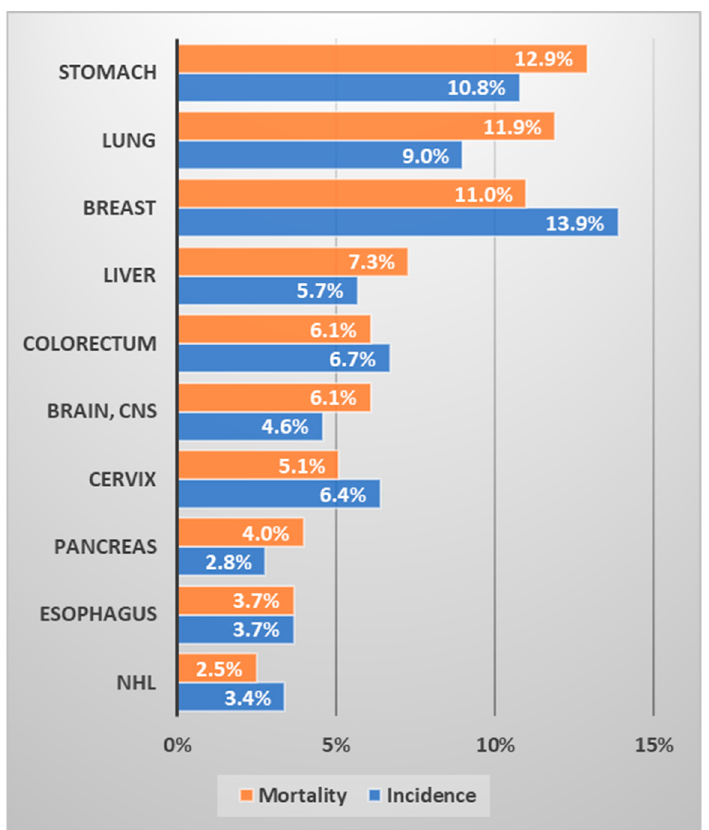
Figure 2. Ranking of the frequency and mortality of major cancers in Uzbekistan (data source: Cancer country profile, WHO, 2020; Global Health Observatory, WHO, 2016. Figure drawn by authors) [12,13].